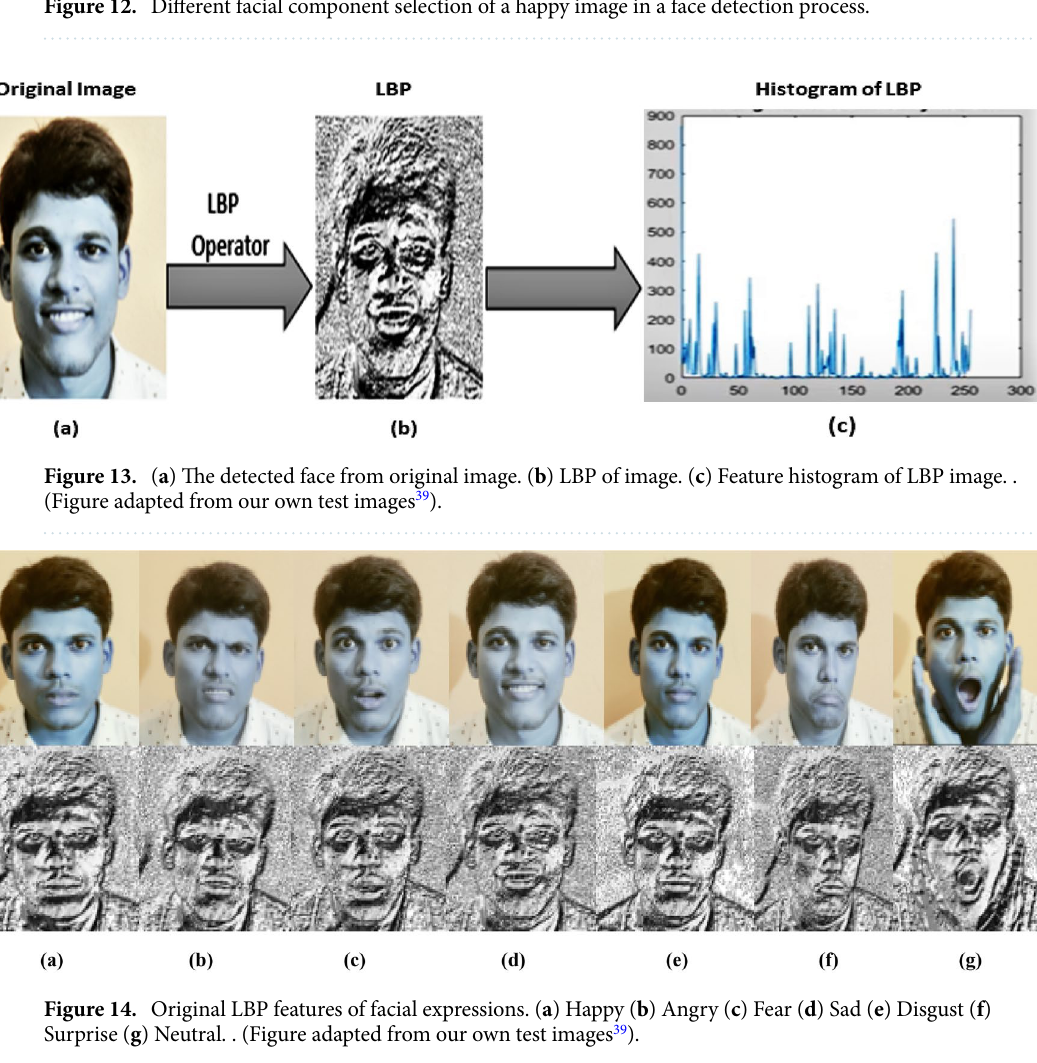
Figure 12. Different facial component selection of a happy image in a face detection process.